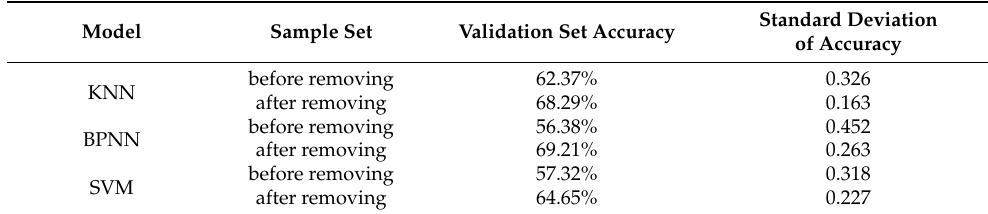
Figure 3. ( a ) Original response curve. ( b ) Response curve after 3-point smoothing filtering. ( c ) Response curve after 5-point smoothing filtering. ( d ) Response curve after 7-point smoothing filtering. ( e ) Response curve after 9-point smoothing filtering. ( f ) Response curve after 11-point smoothing filtering. Table 3. Average accuracy and standard deviation of KNN, BPNN, and SVM pattern recognition models before and after removing